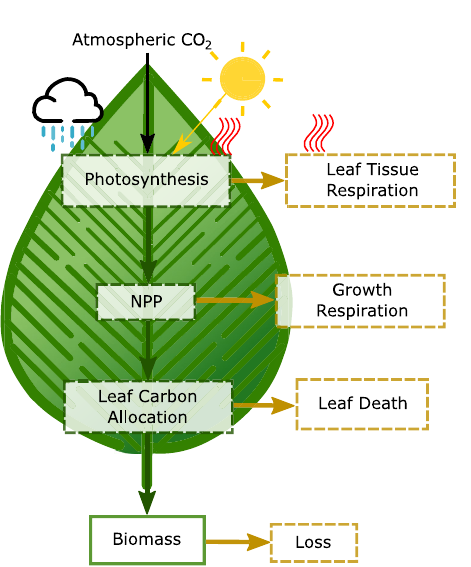
Fig. 1 | Approximate estimations of plant evolution and Phanerozoic time periods. Linesindicate theearliestandlatestoriginof embryophytes, bryophytes, tracheophytes, gymnosperms and angiosperms estimates according to molecular